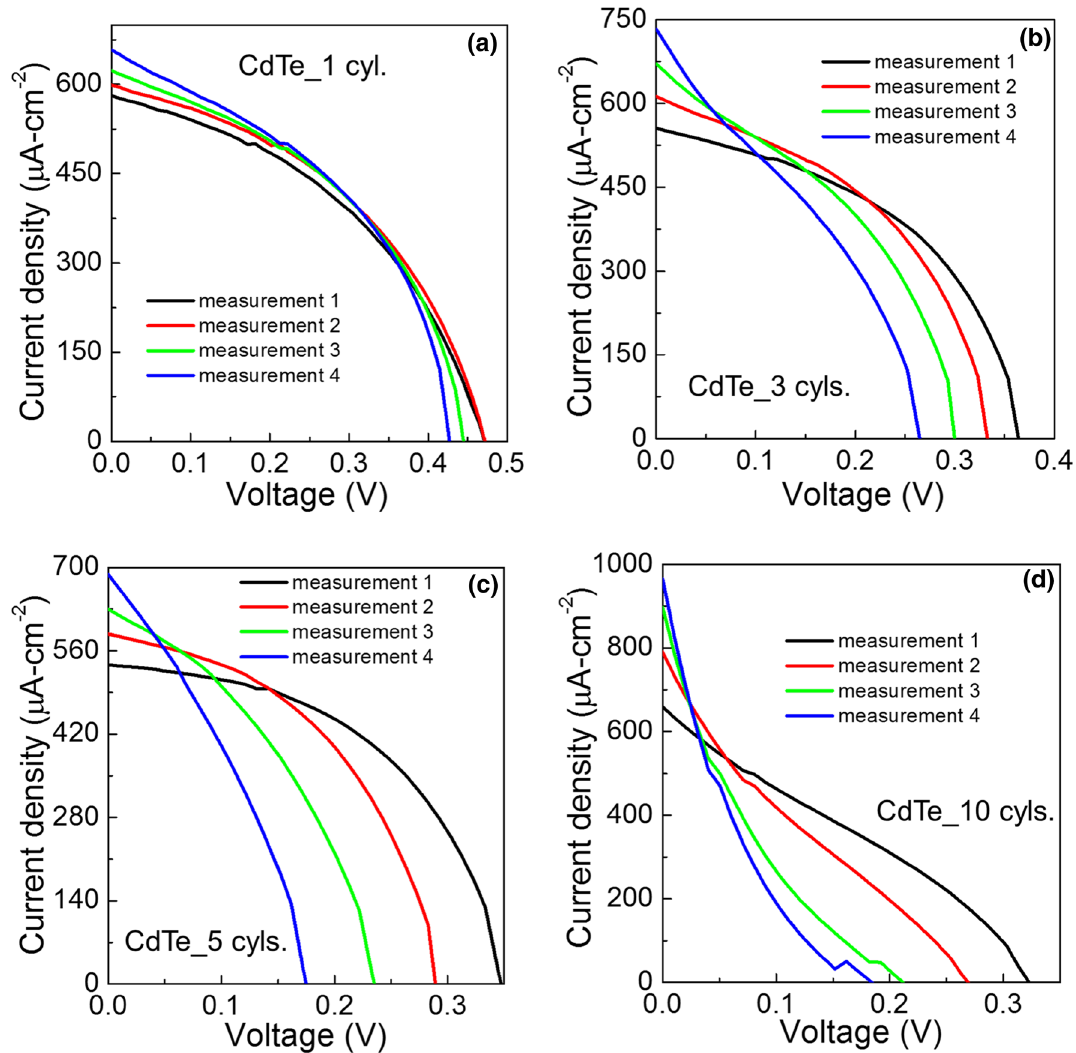
Fig. 5 Illuminated J – V characteristics of the photo-electrochemical cells using heterogeneous CdTe–TiO